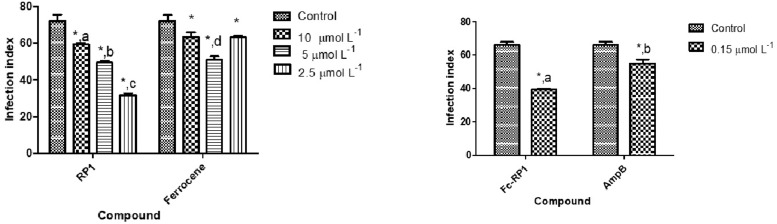
In vitro effect of a) RP1 and ferrocene carboxylic acid and b) Fc-RP1 and Amphotericin B against L. amazonensis intracellular amastigotes. The infection index was calculated after 24 h treatment at the IC50 of each compound. The negative control is L. amazonensis intracellular amastigotes not treated with the compounds. The data are expressed as averages plus standard deviations (SD) from two independent experiments (P <0.01).